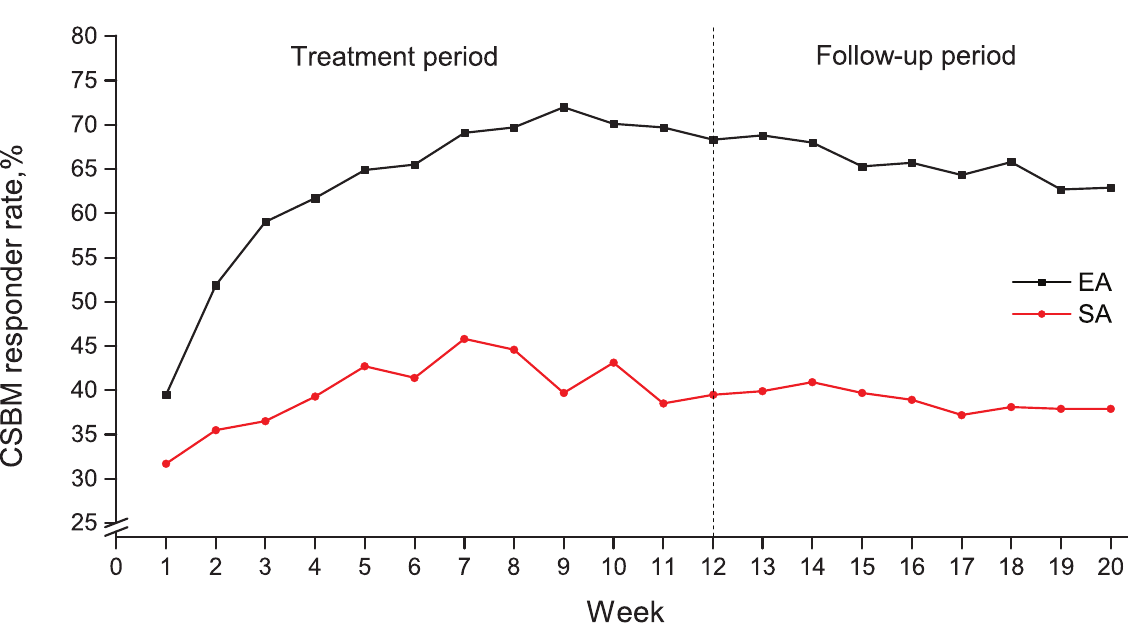
Fig 1. CSBM responder rate in EA and SA groups from week 1 to week 20. The differences in the CSBM responder rate between the two groups were significantin both the treatment and follow-upperiods( P < 0.01).CSBM = completespontaneous bowel movement; EA = electroacupuncture;SA = sham